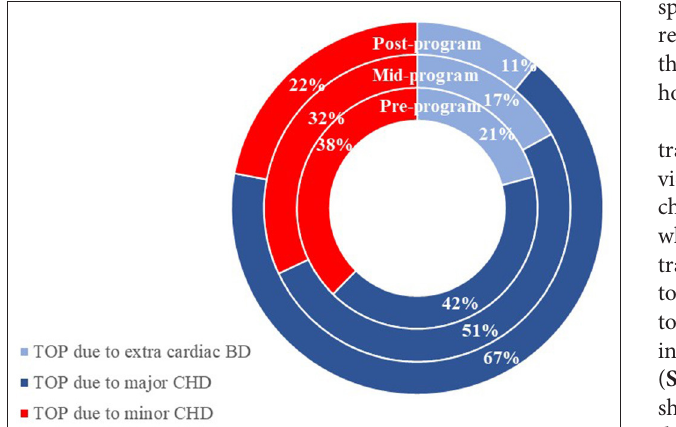
FIGURE 4 | The distribution of the indicators for termination of a pregnancy with a prenatal congenital heart disease diagnosis. BD, birth defect; CHD, congenital heart disease; PDR, prenatal detection rate; TOP, termination of